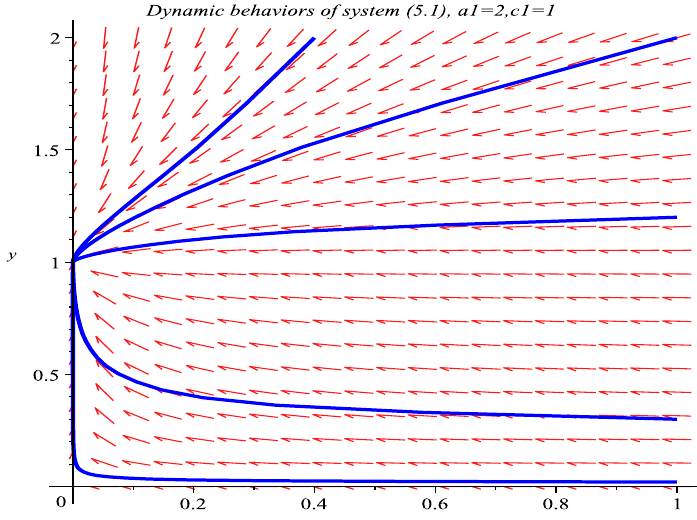
Figure 1. Stability of boundary equilibrium (0,1); here, we take a 1 = 2, c 1 = 1, which includes initial conditions ( x ( 0 ) , y ( 0 )) = ( 1,0.3 ) , ( 0.4,2 ) , ( 1,0.02 ) , ( 1,2 ) , and ( 1,1.2 ) .